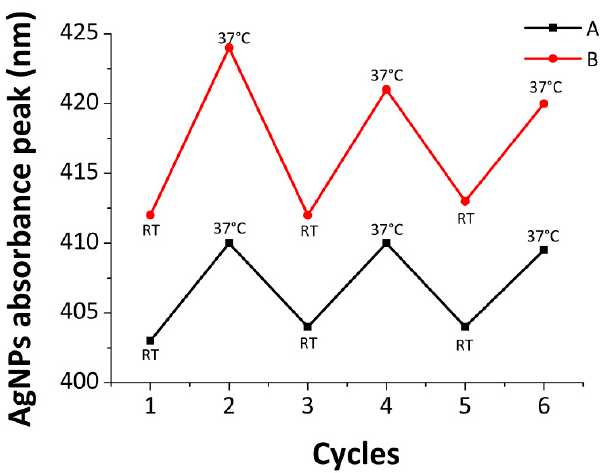
Figure 4. Thermoreversible behavior studied by UV-vis for the polymer A with the ratios ( 3 ) (black) and ( 4 ) (red).